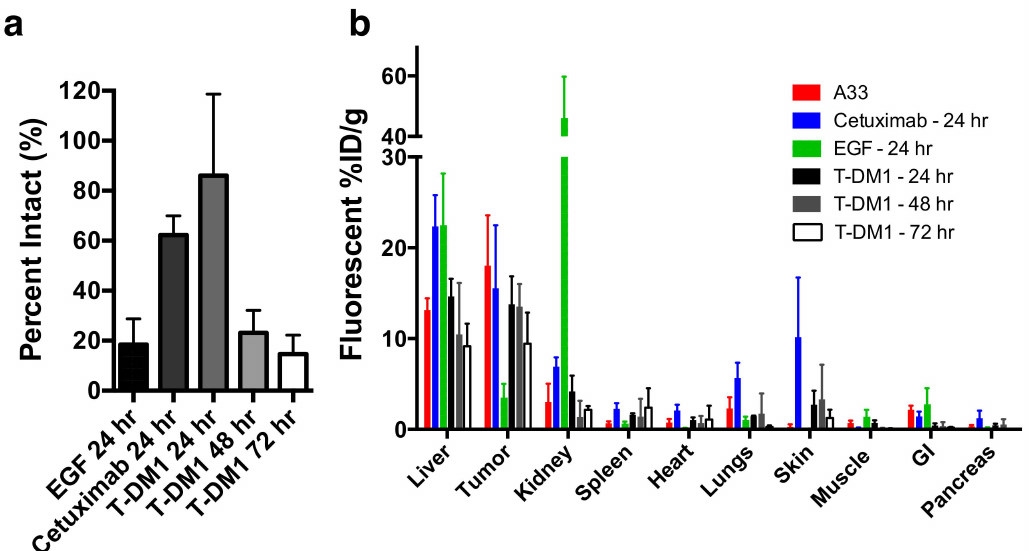
Figure 4. In vivo cellular degradation and distribution. ( a ) T-DM1, EGF, and cetuximab degradation in tumor cells. At 24 h EGF (a rapidly clearing protein), is mostly degraded in the tumor. However, the slowly clearing cetuximab and T-DM1 show mostly intact protein. Over 48–72 h, after maximum uptake is reached, T-DM1 is increasingly degraded. Data plotted as mean ± standard deviation. ( b ) Fluorescence biodistribution of EGF, cetuximab, and A33 at 24 h and T-DM1 at 24, 48, and 72